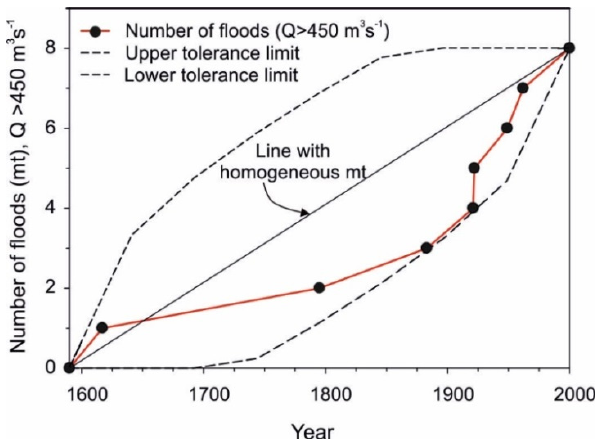
Figure 9. Stationary test on the time flood process at the Montlleó River over the period CE 1590–2000, for flood exceeding a discharge threshold of 450 m 3 s − 1 . The null hypothesis is to assume that the distribution of the number of exceedences can be described by a homogeneous Poisson process (i.e., independent and identically distributed random variables; [50]). The test is passed when the accumulated flood line (red line with black dots) stays inside the 90% tolerance interval (95 and 5% quantiles; dashed lines), implying the compliance of the Poisson process hypothesis.